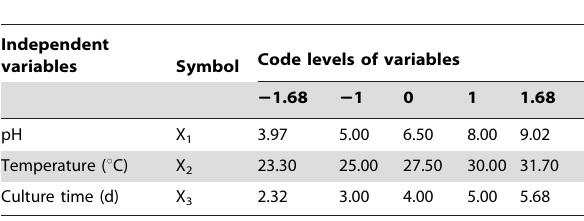
Table 1. The symbols and levels of three independent variables used in central composite rotatable design